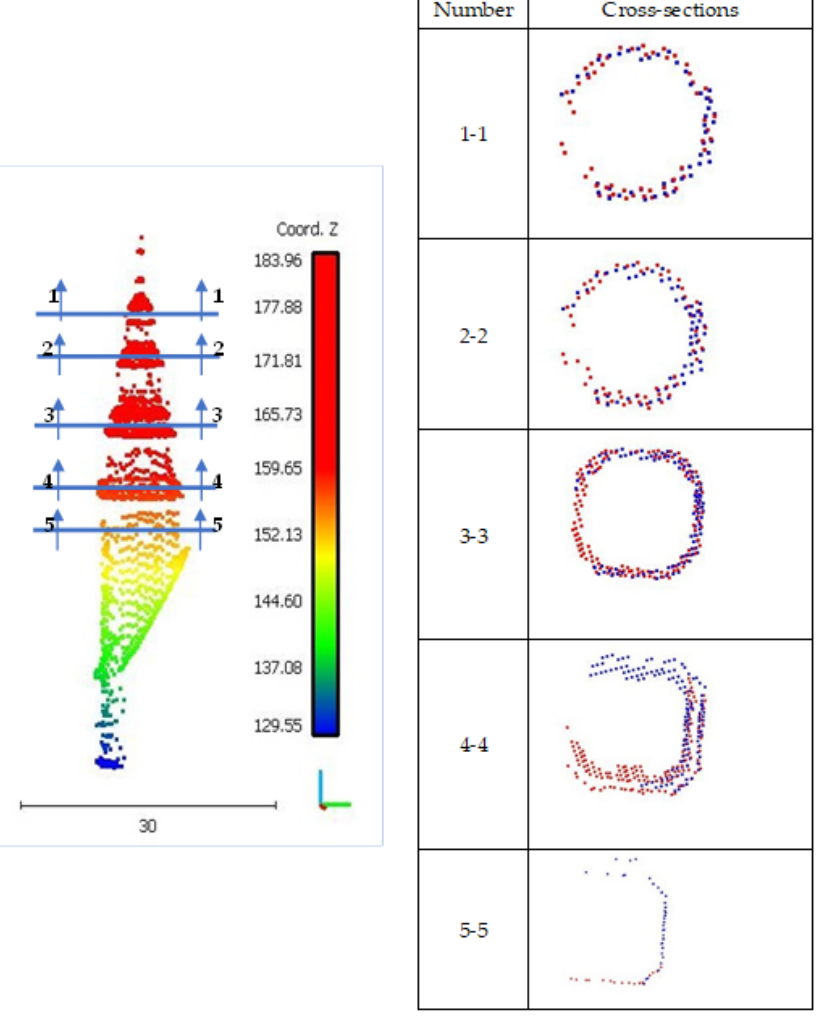
Figure 3. Five cross-sections in the tower point cloud.